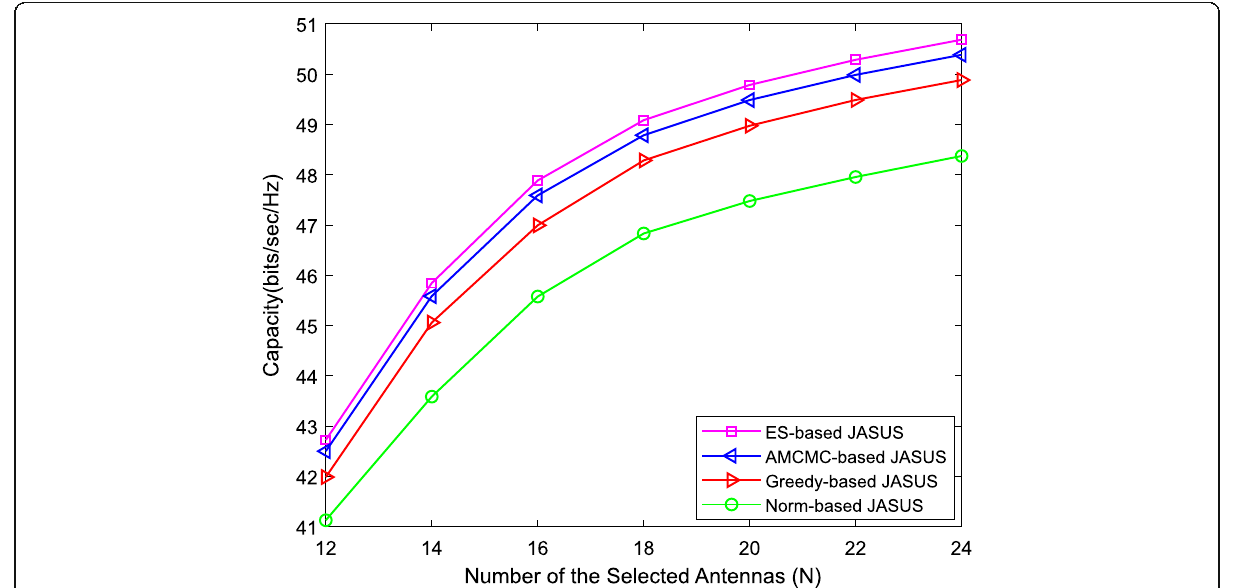
Fig. 6 Ergodic capacity of different algorithms with different numbers of the selected antennas with B = 7, M = 64, U = 50, K = 10, and SINR = 20